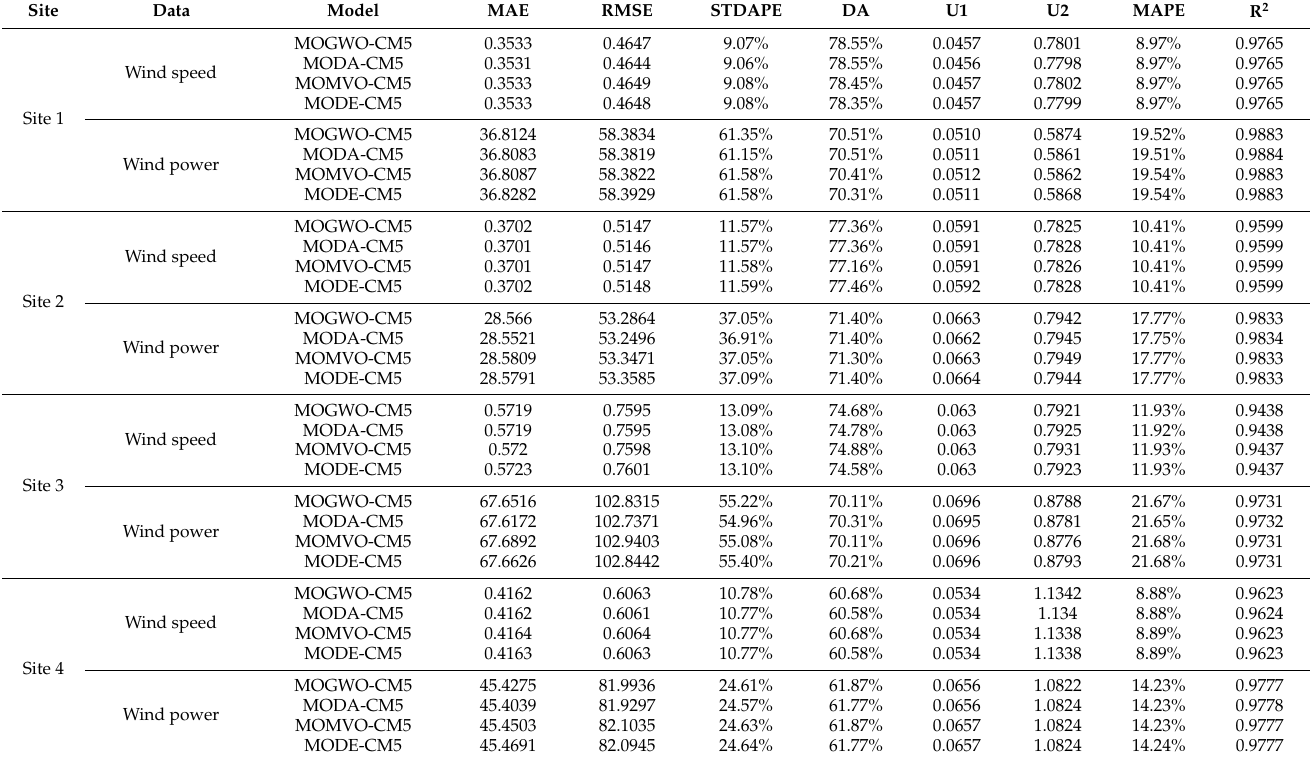
Table 5. Wind speed forecasting result for each site by different models in the second